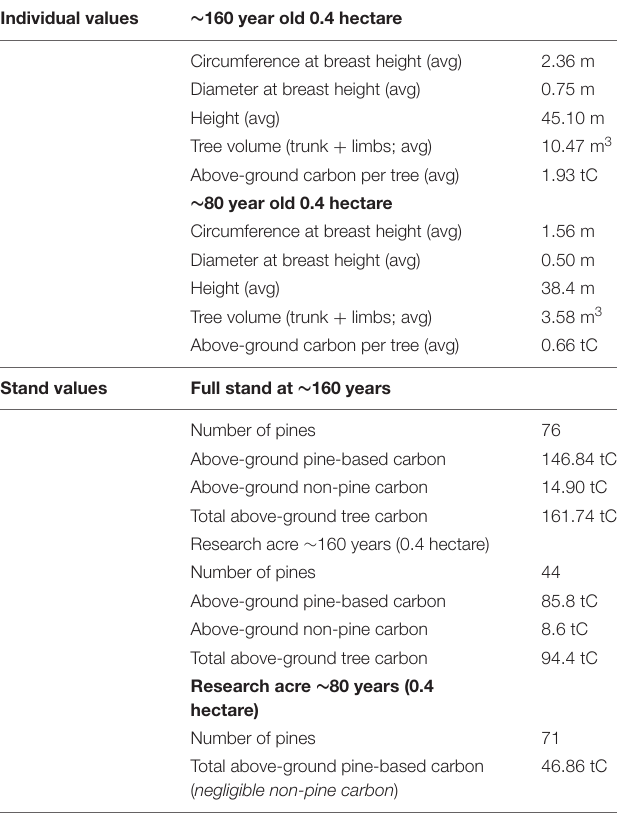
TABLE 1 | Summary of key measurements within a 160-year pine stand ( TOP ) and a comparable ∼ 80 year old stand (2018–2019 values). Individual